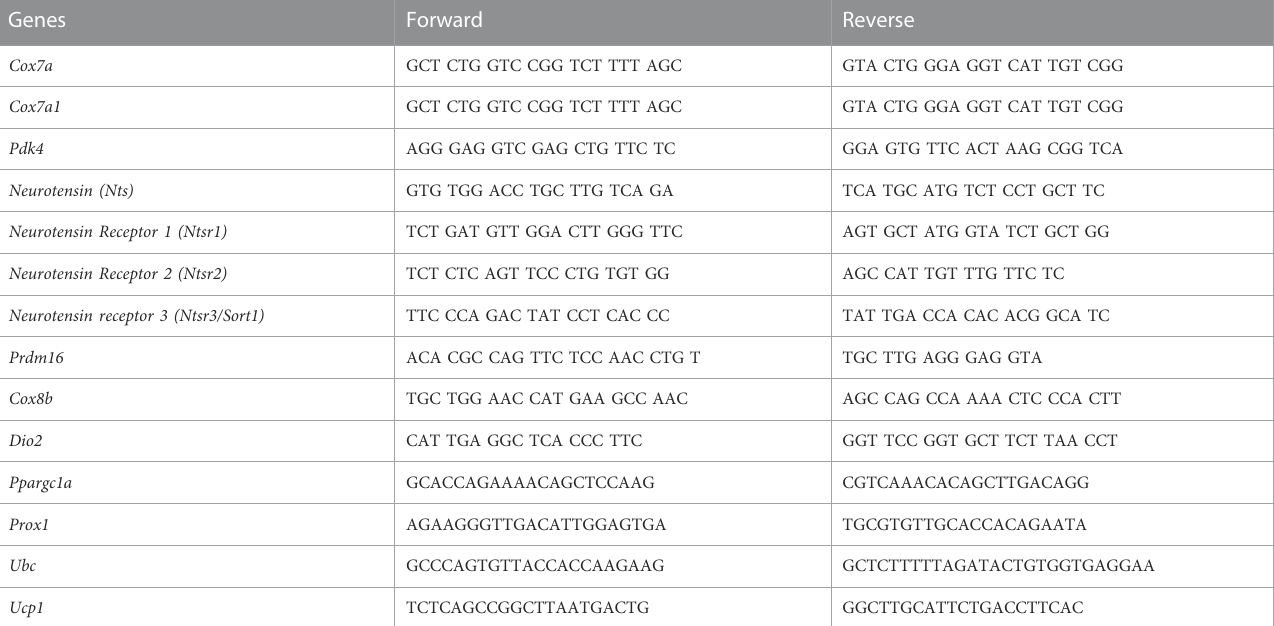
TABLE 1 Primers and sequences utilized in this